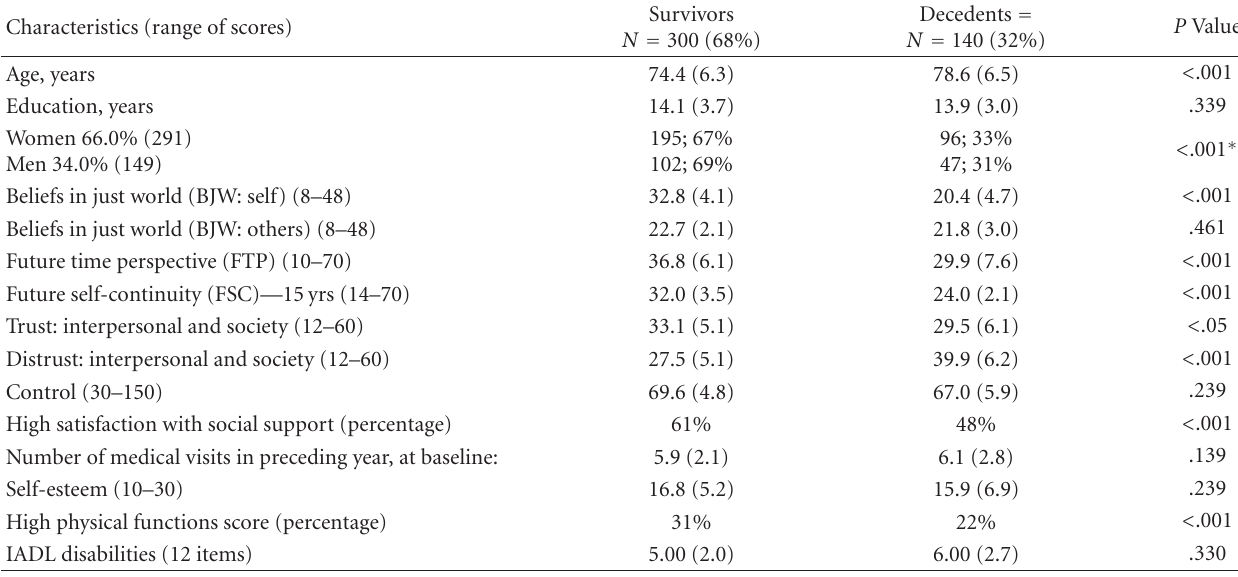
Table 1: Baseline characteristics of participants who survived (survivors) or died (decedents) Total N = 440. Characteristics (range of scores)